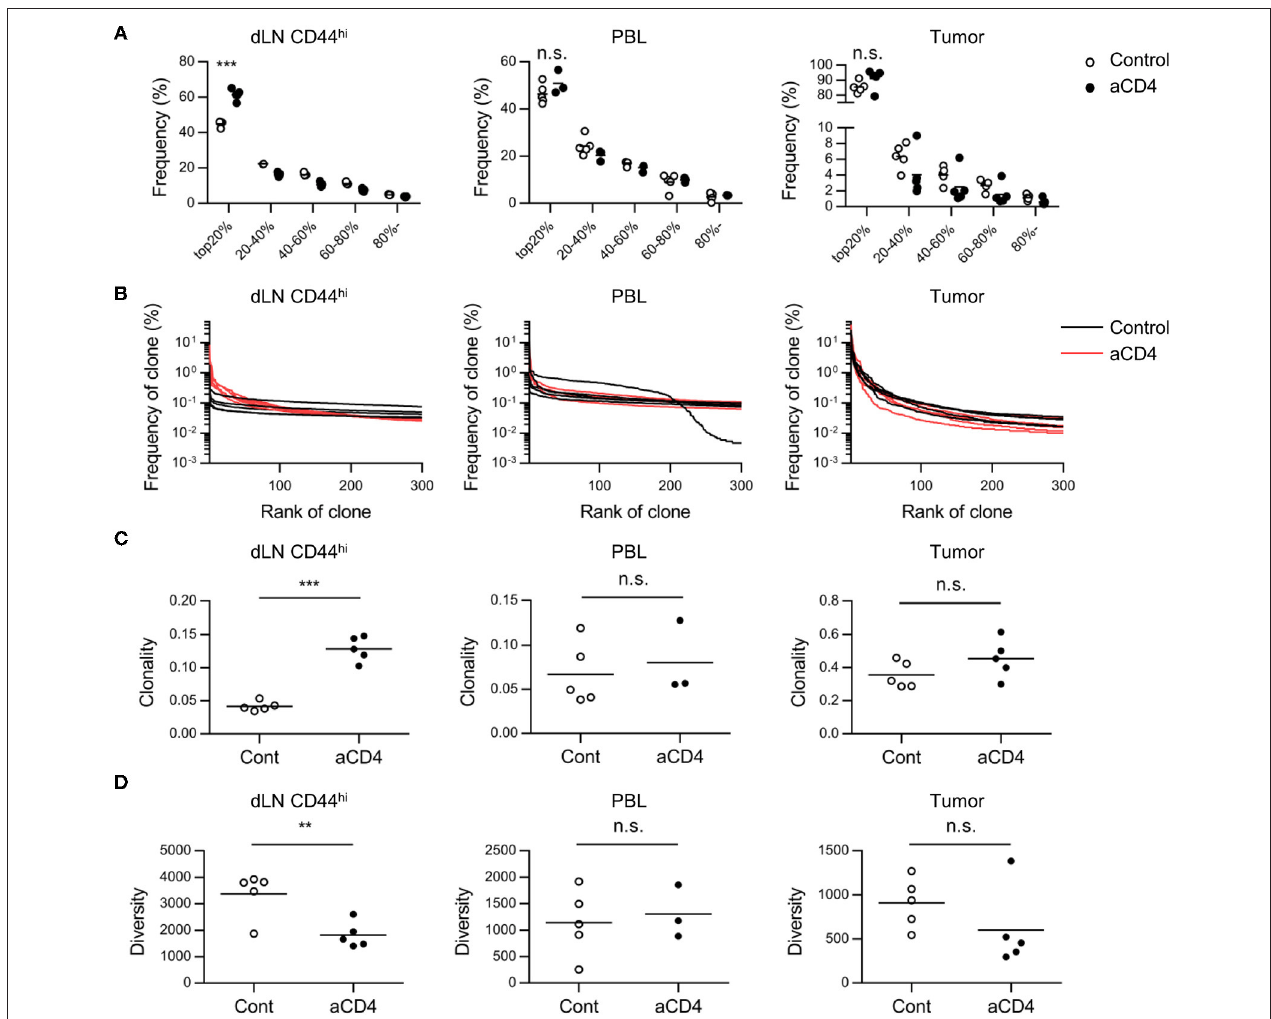
FIGURE 3 | Anti-CD4 mAb treatment triggered the expansion of high frequency clones in dLN. Mice bearing B16F10 tumors were injected i.p. with anti-CD4 mAb on days 5 and 9, and were analyzed on day 14 after tumor inoculation. (A) Quantile statistics of the dLN CD44 hi , PBL, and tumor repertoire. (B) Distribution plots of the dLN CD44 hi , PBL, and tumor repertoire. The x-axis represents each clone in the descending order of frequency, and y-axis represents the frequency of each clone in the dLN CD44 hi , PBL, and tumor repertoires. (C,D) Clonality (C) and diversity (D) of the dLN CD44 hi , PBL and tumor repertoire. Clonality was calculated as 1-Pielou index (method). Diversity was defined as the number of clones with a frequency of > 0.01%. All figures present the data for TCR β . Two-sided unpaired Student’s t -tests ( n = 5, except for PBL of aCD4: n = 3). ** P < 0.01; *** P <